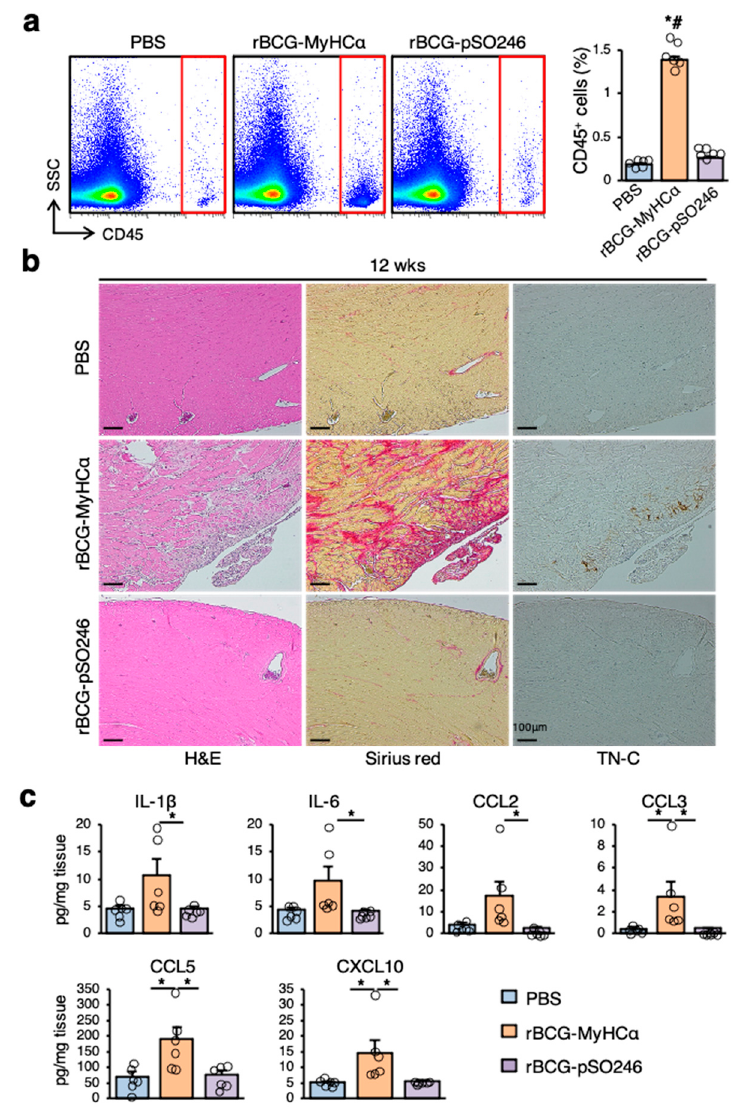
Figure 4. rBCG-MyHC α immunization induced chronic heart inflammation in mice. Immunization protocol is shown in Figure 1a. ( a ) Representative flow cytometric plots showing CD45 + leukocyte infiltration in hearts from mice at 12 weeks after rBCG immunization. Bar graph shows the quantification of CD45 + leukocytes as a percentage of live cells. Results are presented as mean ± SEM, n = 6 each, * p < 0.05 vs. PBS and # p < 0.05 vs. rBCG-pSO246 by Kruskal-Wallis analysis with a post hoc Steel-Dwass test. ( b ) Representative histology (H&E and Sirius red staining and TN-C immunostaining) of the heart sections at 12 weeks after rBCG immunization. ( c ) Cytokine and chemokine secretion in homogenized hearts obtained from indicated mice at 12 weeks after rBCG immunization was assessed by an ELISA. n = 6 per group. * p < 0.05 by Kruskal-Wallis analysis with a post hoc Steel-Dwass test.